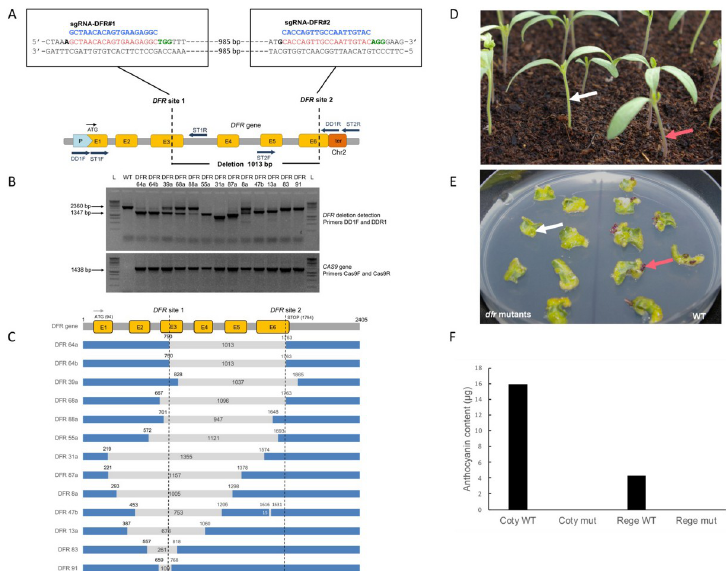
Fig 1. CRISPR-Cas9 mediated deletion in DFR marker gene. (A) Schematic illustration of the double sgRNA strategy targeting the DFR gene in exon 3 and exon 6 (E3 and E6 yellow boxes). The PAM site is in green, the target sequence in red and the sgRNA in blue. The promoter and terminator sequences are represented with pale blue and orange boxes, respectively. The expected length of the deletion generated by the use of these two sgRNAs is 1013 bp. The positions of the primers used for detection and sequencing are shown with dark blue arrows. (B) PCR analysis of the DFR locus using primers DD1F and DD1R in 13 independent T0 plants. The amplicon sizes for the wild-type genomic locus and for the predicted deletion are 2360 bp and 1347 bp, respectively (see arrows). The presence of the CAS9 gene in the T0 plants was confirmed by PCR analysis using primers Cas9F and Cas9R. (C) Schematic representation of the deletion pattern observed in the DFR gene for the 13 T0 plants analysed. The numbers inside the grey section represent the deletion size and the numbers next to the blue sections represent the position of the cut in the DFR gene. (D) Emerging hypocotyls observed on 10 day old progeny of a T0 tomato plant that was heterozygous for the DFR gene deletion. Segregating T1 plantlets homozygous for the mutated DFR gene showed an absence of anthocyanin pigmentation in their hypocotyls (white arrow). Segregating T1 plantlets homozygous or heterozygous for the wild-type DFR gene showed anthocyanin pigmentation (red arrow). (E) Regeneration from cotyledon pieces two weeks after induction. Left: cotyledons of T2 plantlets issued from the dfr mutant T0 plant DFR64a; Right: cotyledons of wild-type WVA106. Anthocyanin pigmentation (red arrow) was observed in the first days of regeneration while it was not visible (white arrow) in dfr regenerating buds. (F) Anthocyanin content analysis ( μ g equivalent cyanidin- 3-glucoside per g of fresh weight) by high-performance liquid chromatography on cotyledons and regenerating plantlets in wild type and dfr mutants. Coty WT: WVA106 wild-type cotyledon extract; Coty mut: dfr mutant extract; Rege WT: wild-type regenerating plantlet extract; Rege mut: dfr mutant regenerating plantlet extract. Anthocyanin contents were not detected in the mutant extracts with a minimal level of detection of 0.05 μ g/g.